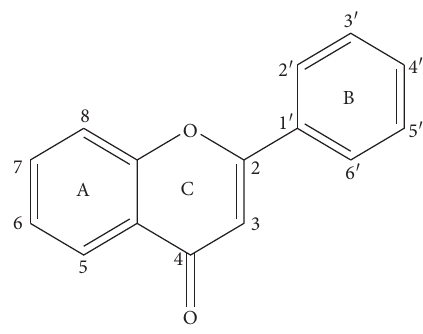
Figure 1: Basic skeleton of flavonoids.